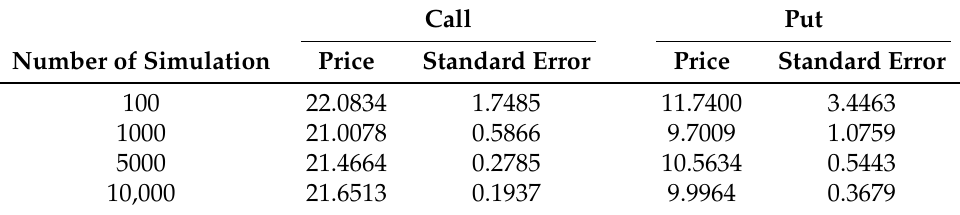
Figure 8. Bootstrapping for Asian call ( left ) & put ( right ). Table 9. MCS prices and standard errors for Asian call &